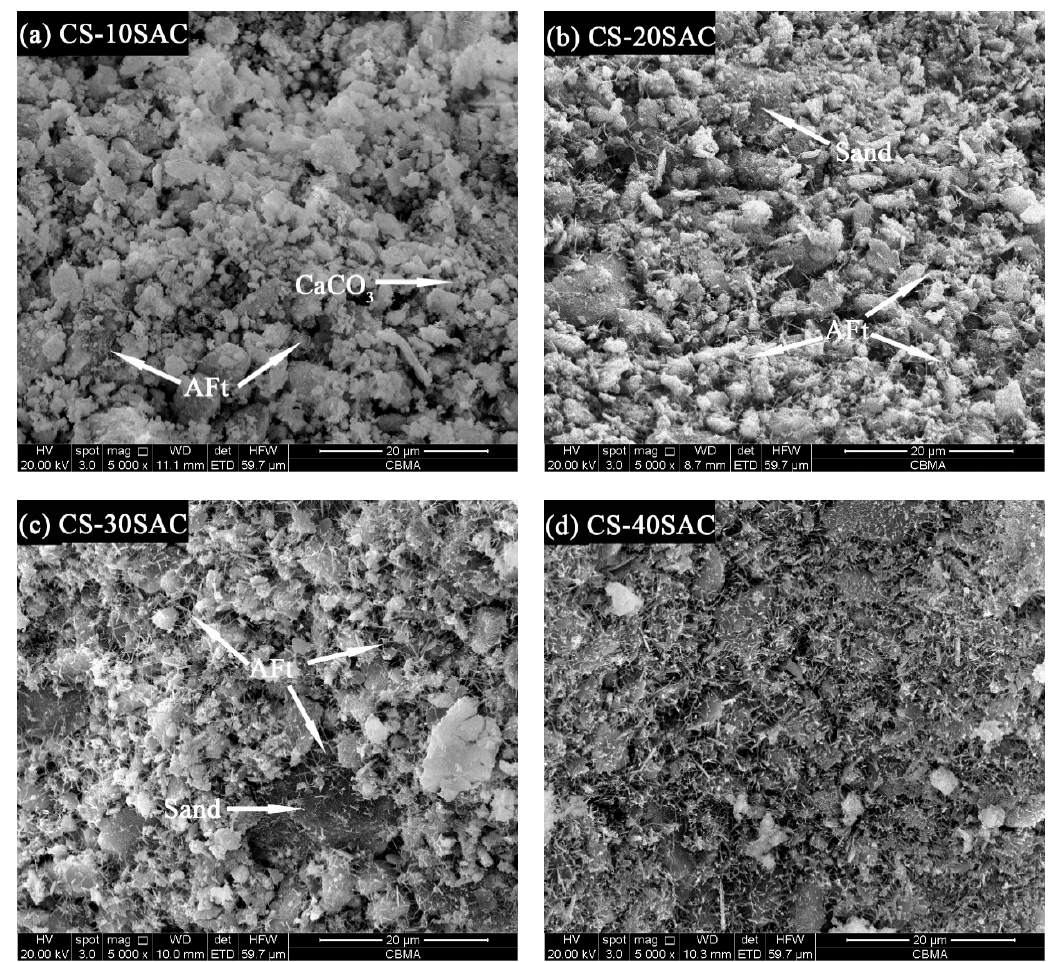
Figure 11. SEM images of blended mortars at 28 d: ( a ) CS-10SAC; ( b ) CS-20SAC; ( c ) CS-30SAC; ( d ) CS-40SAC.